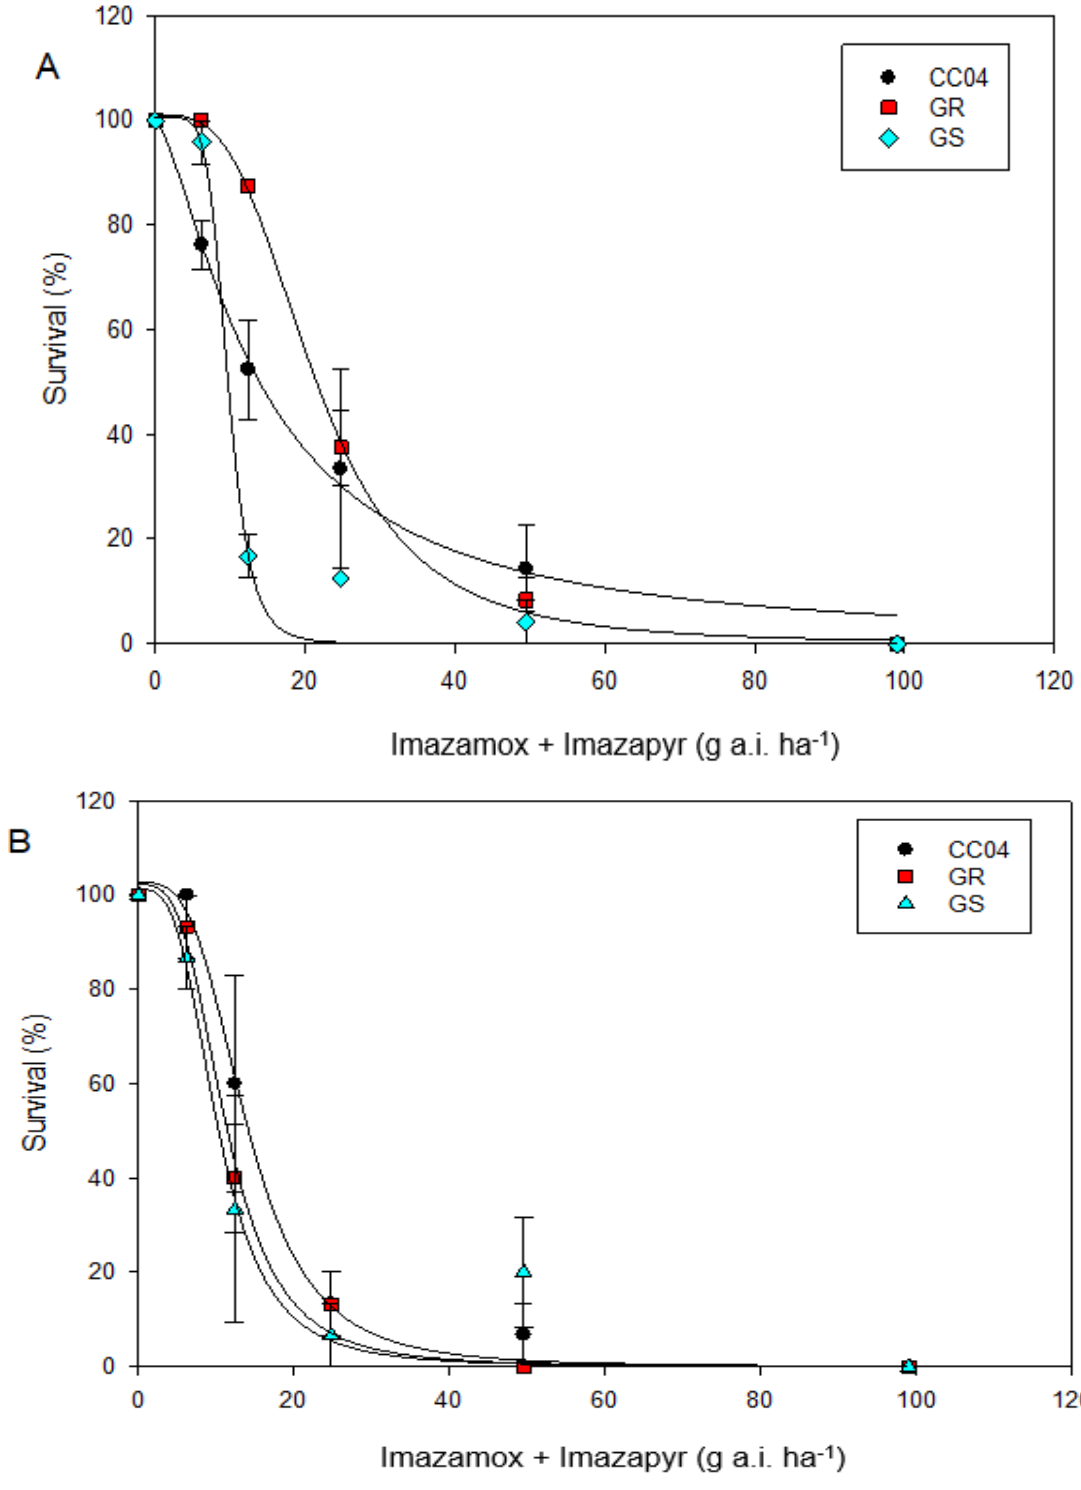
Figure 4. Survival response of three Lolium rigidum populations (CC04, GR, and GS) to six rates of imazamox + imazapyr in ( A ) 2019 and ( B ) 2021. Data are presented as the average percentage of plants that survived and error bars represent the standard error of the mean.